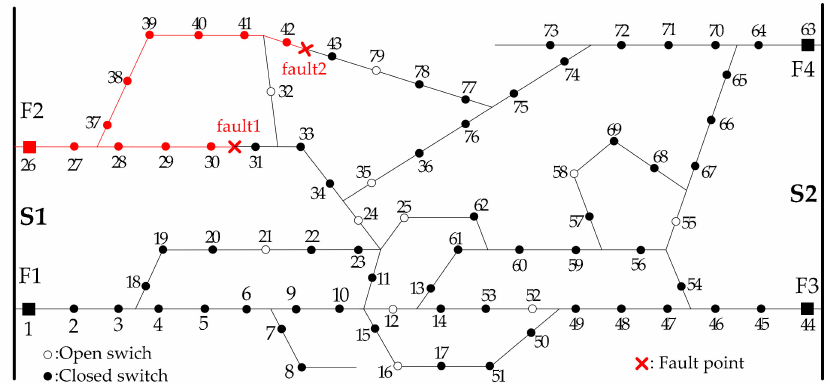
Figure 14. Simultaneous faults in different laterals in the same feeder